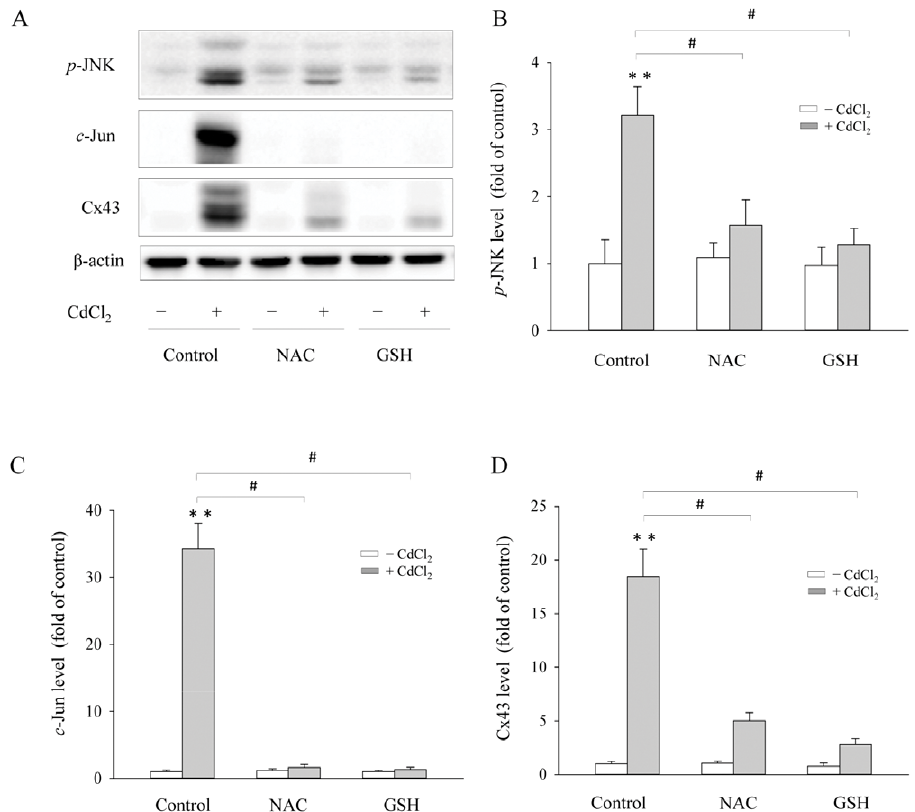
Figure 3. Effects of GSH-upregulating agents on Cd 2 + -elicited Cx43 expression. Cx43-LLC-PK1 cells were pretreated with 2 mM GSHee or 2 mM NAC for 1 h and exposed to 35 m M Cd 2 + for additional 6 h. Cellular protein was subjected to Western blot analysis for p -JNK, c -Jun, Cx43 and b - actin (A). Densitometric results (B–D) were expressed as induction relative to the basal level of p -JNK, c -Jun and Cx43, respectively (mean 6 S.D., n=3). # p , 0.01 versus Cd 2 + alone, and ** , 0.01 versus untreated